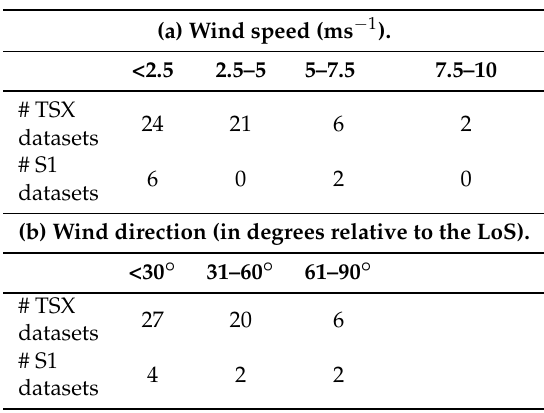
Table 3. Data collection: available datasets per experiment type. Experiment